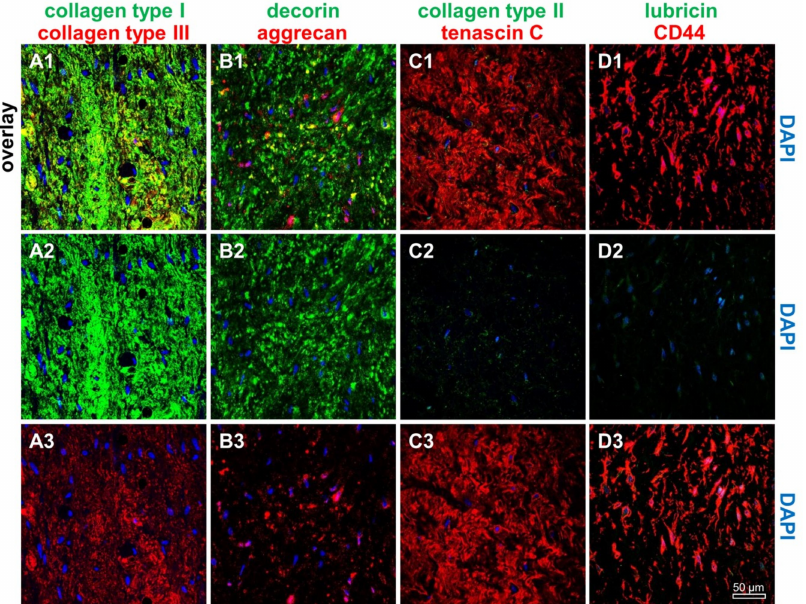
Figure 1. Immunohistological characterization of the human anterior cruciate ligament (ACL) donor tissue. Immunolabeling of ACL extracellular matrix components and CD44 (hyaluronan receptor) was performed using the human ACL donor tissue. ( A1 – A3 ) Collagen type I (green) and type III (red), ( B1 – B3 ) decorin (green) and aggrecan (red), ( C1 – C3 ) collagen type II (green) and the fibroblast / ligamentocyte marker tenascin C (red), ( D1 – D3 ) lubricin (green) and CD44 (red). Cell nuclei were counterstained using 4 (cid:48) ,6 (cid:48) -diamidino-2-phenylindol (DAPI, blue). Scale bar: 50 µ